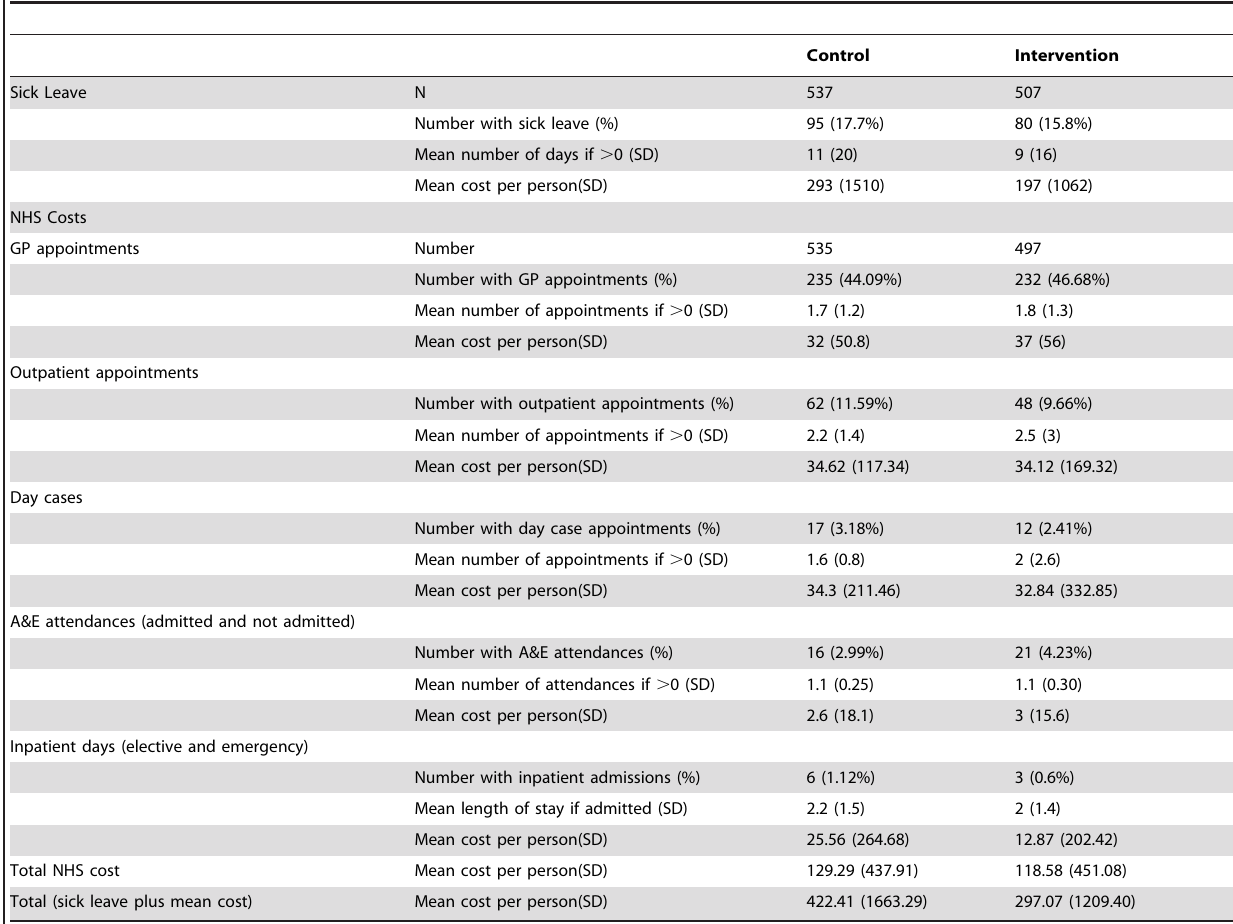
Table 3. Costs related to number of days of sickness absence and number and duration of hospital admissions in the past three